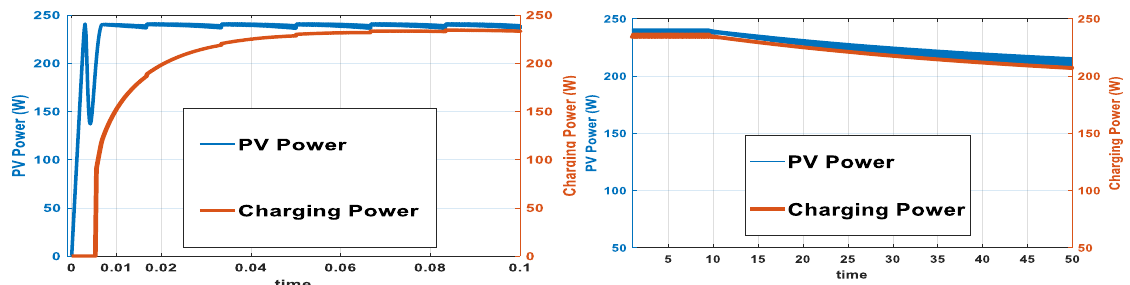
Figure 5 . Voltage and current charging curve at the beginning and regulation phase.